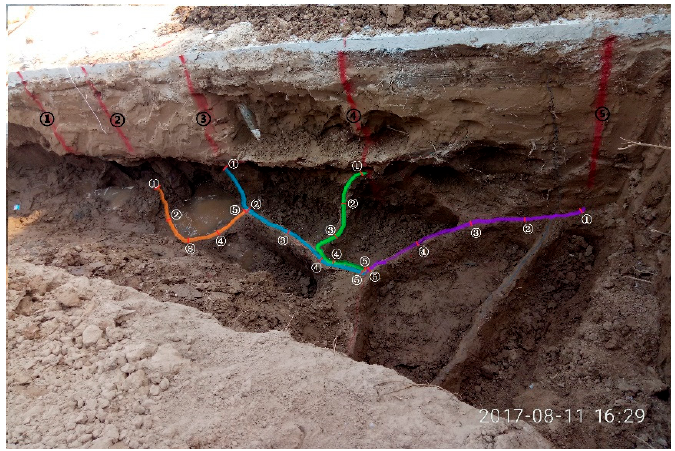
Figure 15. Pit prospecting result.